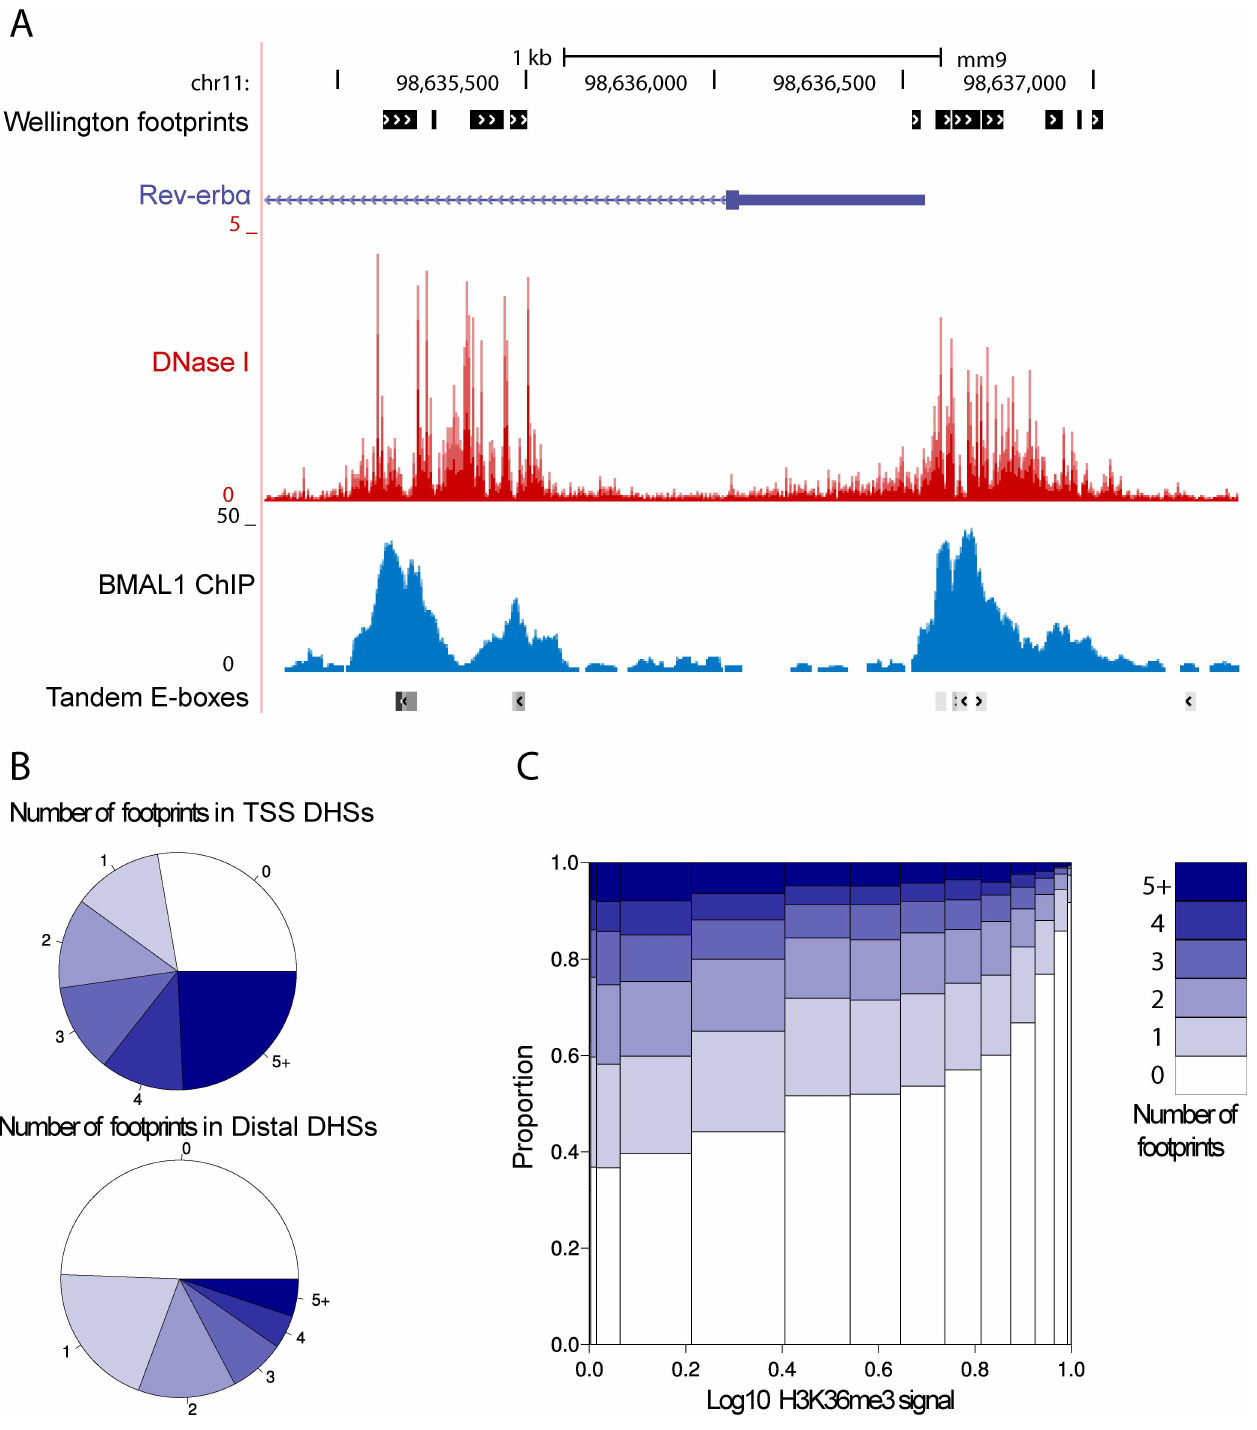
Fig 2. Location-dependent footprint characteristics of DNase I Hypersensitive Sites (DHSs). A. Visualization of DNase I signal (red) around the Rev-erb α promoter with the footprints (detected by Wellington)annotated in black, on top. This regioncontainsBMAL1-bindingsites (blue) with E-box motifs, annotatedon the bottom line, which is marked by a characteristic footprint. The DNase I cleavagepattern is lower at the bindingsite, reflecting protection of the DNA from digestion, whereashigh signalsare observed on the edges of the bindingsite. B. Number of footprints within DHSs ( ± 300bp aroundthe peak center). TSS regionscontain more footprints on average. More than half of distal regions containa footprint. C. Number of footprints detected in DHSs in function of (relative) H3K36me3signal[12].